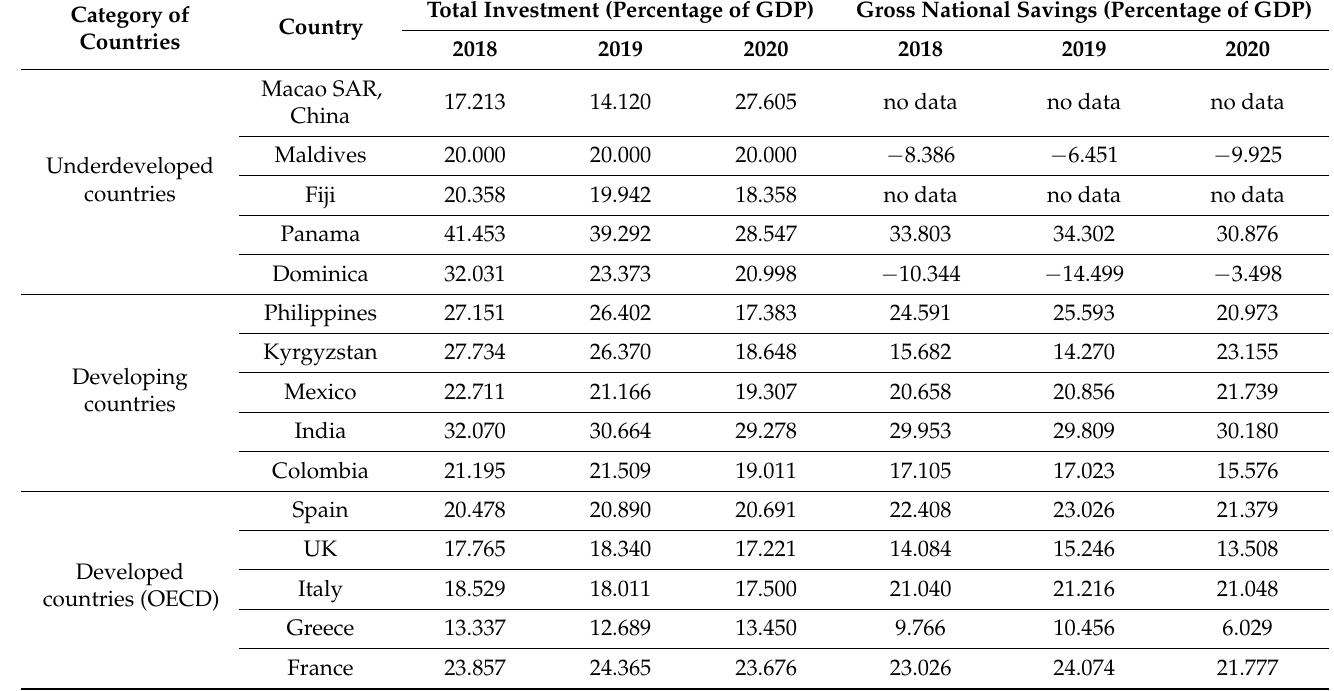
Table 3. Statistics characterizing market-determined risks in the highlighted categories of countries in 2018–2022.